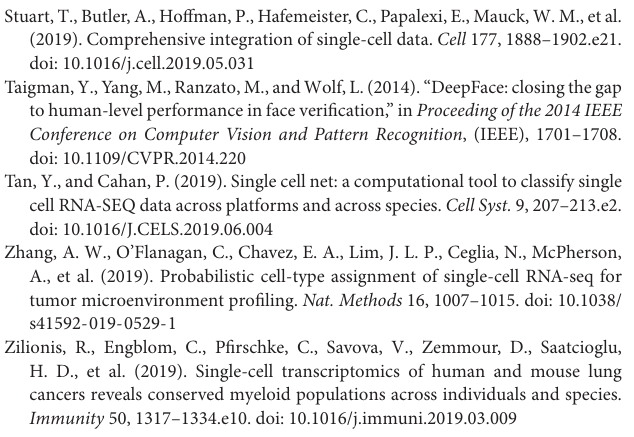
Heatmap representation of the neural network firing pattern where each row is a cell and each column a single neuron in the final output layer. Supplementary Figure 2 | Annotation performance of MapCell. Speed of MapCell annotation on a local desktop with a RTX-2080 GPU. Supplementary Figure 3 | Contrasting Cosine and Euclidean against SNN distances for distinguishing cell state. (A) Peripheral B cells (bB cells) and tumor derived B cells (tB cells) from the test set are compared against the reference cell types in the training set. (B) Boxplot showing the distibution of signal-to-noise values for the different distant metrics for blood and tumor derived B-cells. Supplementary Figure 4 | Alluvial plot depicting the switch in novelty status and annotation status when incorporating left out subtypes during training of SNN models. (A) Mapping of cell types based on SNN trained on major cell type selected training examples. (B) Mapping of cell types based on SNN trained on minor cell type selected training examples. Addition of omitted minor clusters of cell types redirects the annotations from novel to identifiable, and each to its respective expected human annotated states. The process depicts the capability of the SNN network to be used as an novelty detector as well as the plasticity of such a process to allow for subsequent update of novel classes. Supplementary Figure 5 | Siamese derived embedding space. (A) K-nearest neighbor (KNN) graph network of Siamese Network embedding space trained on a single patient. (B) Projection of cell types not trained in the initial network onto embedding space. (C) KNN graph network of Siamese Network embedding space with new cell types